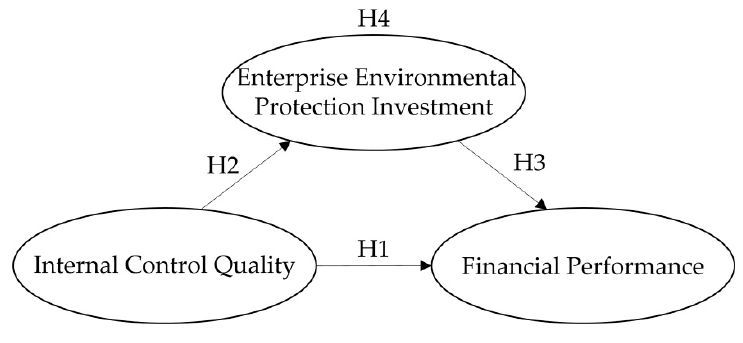
Figure 1. Theoretical model.